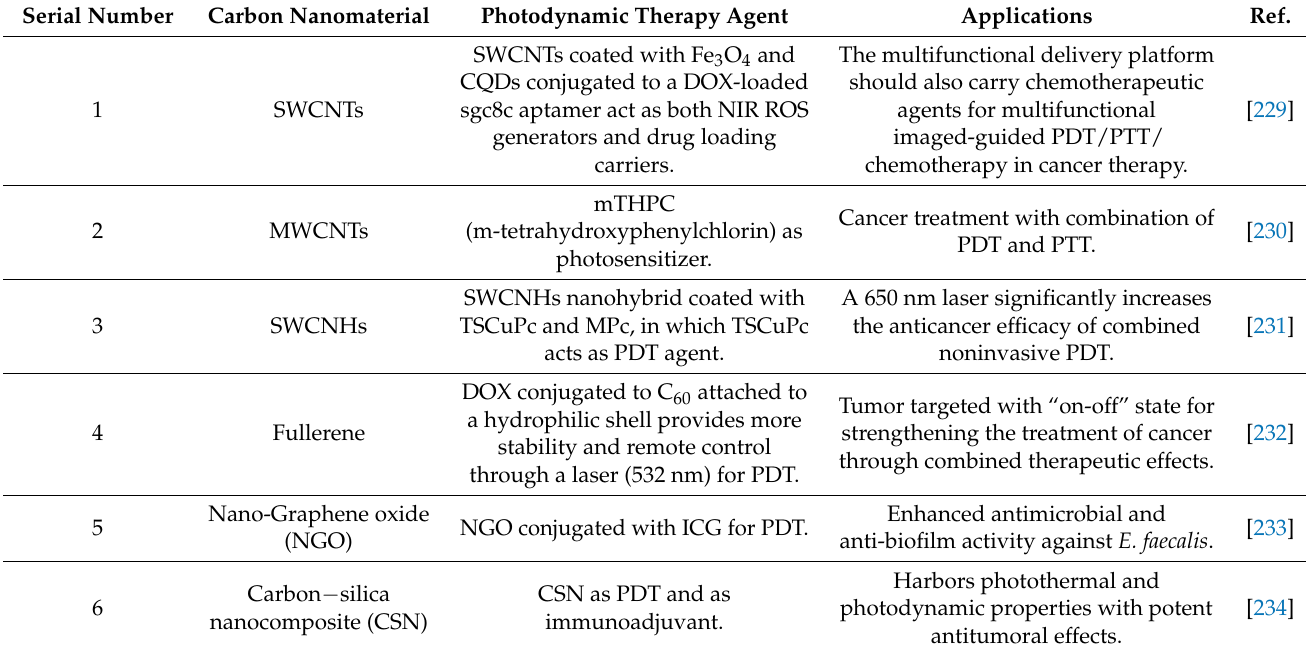
Table 9. Different CNMs used in PDT applications.